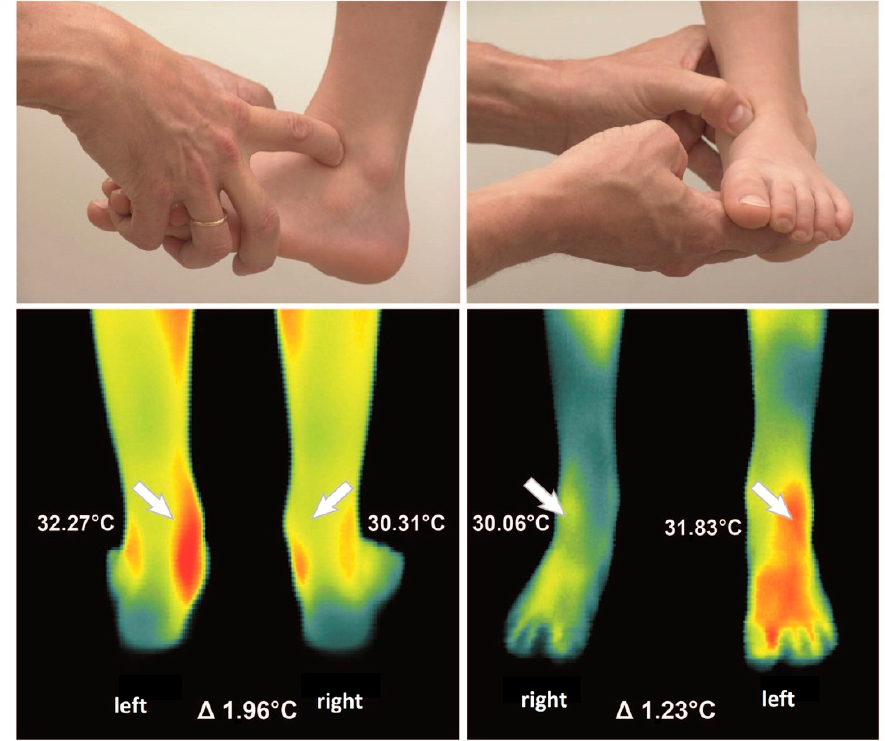
Figure 3. Example of a clinical examination of the antero-lateral and antero-medial capsule of the ankle joint ( upper part ). The thermographic examination of right/left differences of the ankle joint in front and rear view ( below ) showed marked right/left differences of 1.96 °C in the rear view on the tibialis posterior tendon and of 1.23 °C in the front view on the antero-lateral capsule.